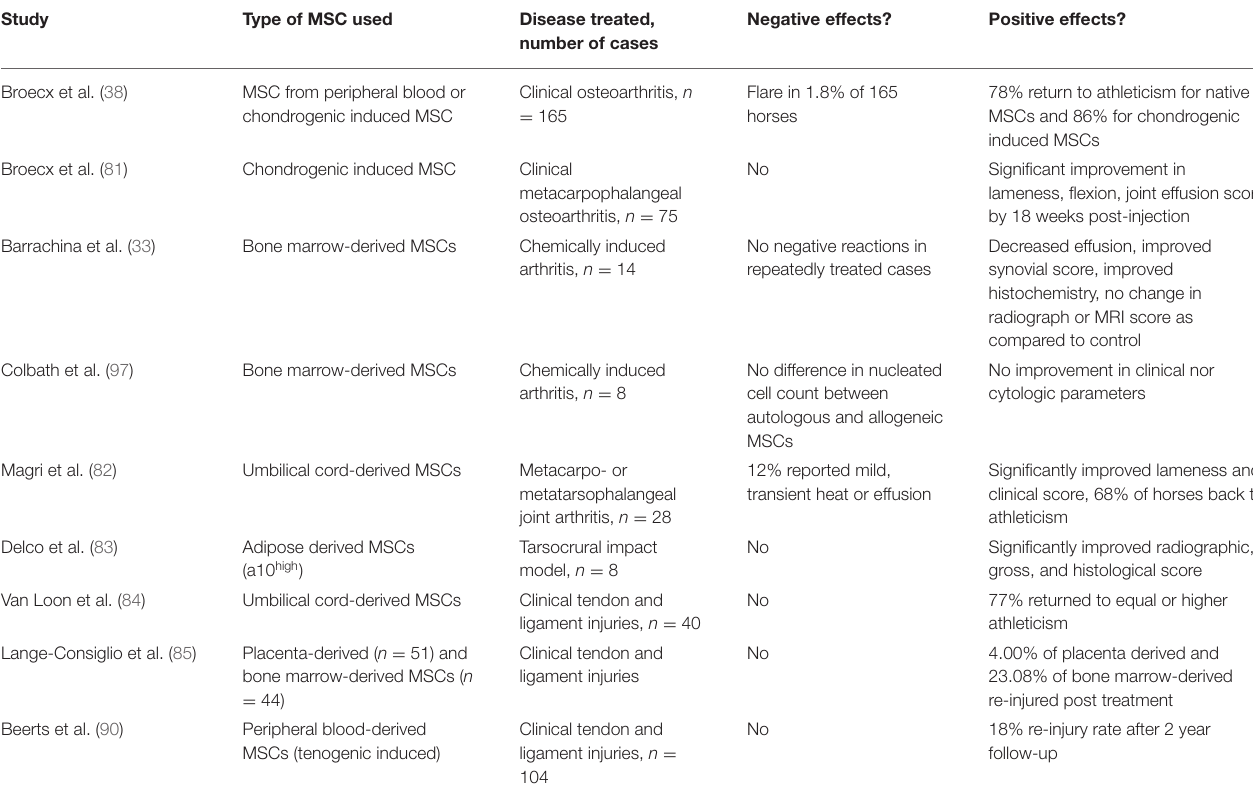
TABLE 2 | Relevant equine studies evaluating the use of allogeneic MSCs in clinical and experimental musculoskeletal